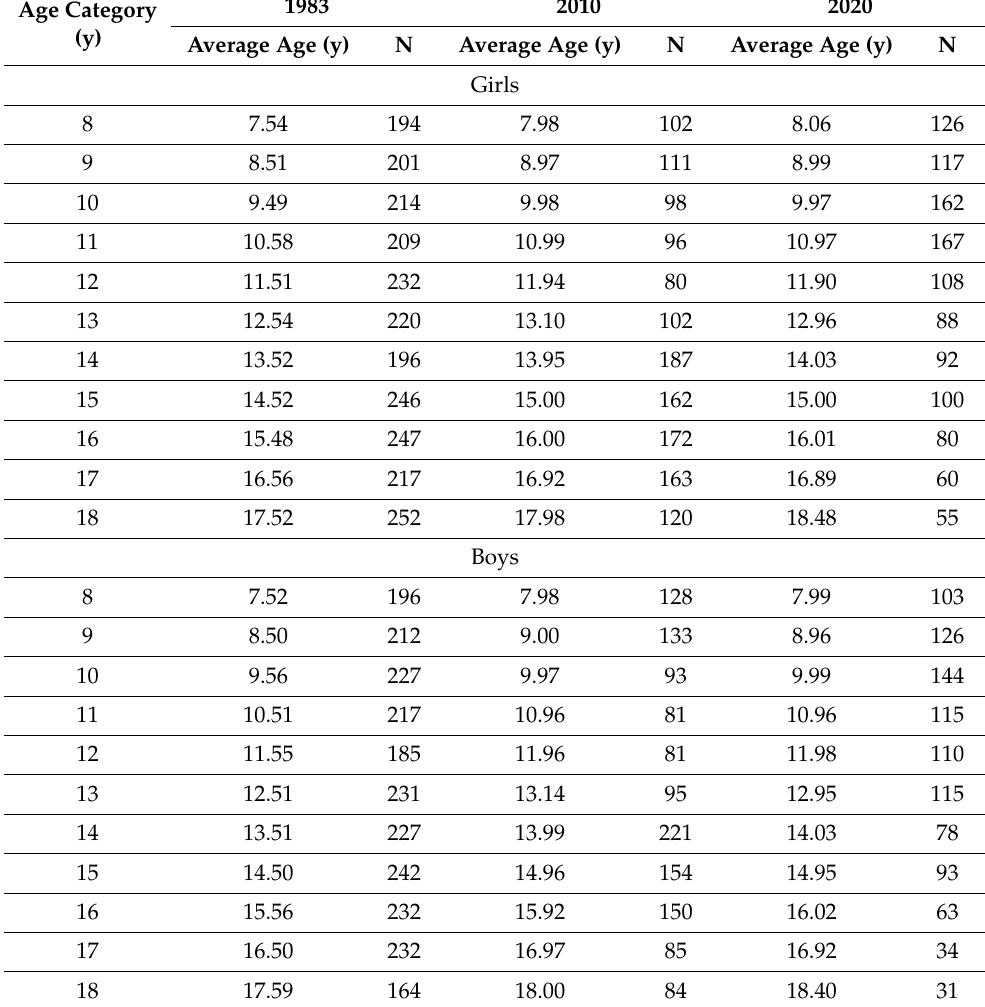
Table 1. Number of individuals and mean participants’ age in each of the examined